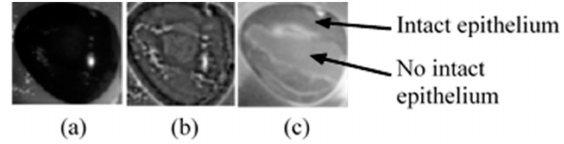
Figure 16. Imagecomparisonbeforeandafterenhancement. ( a )originalwithoutstain; ( b )afterenhancement (without stain); and ( c ) ground truth with stain.